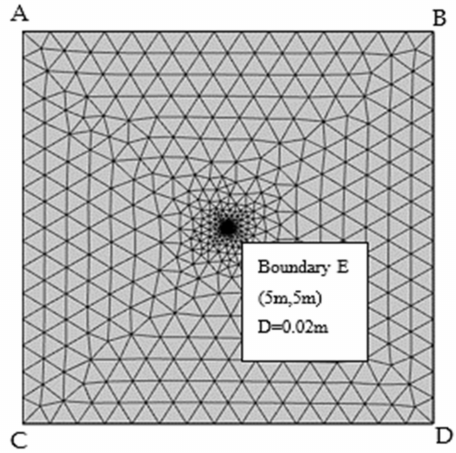
Figure 4. Coal underground gasification flow chart.